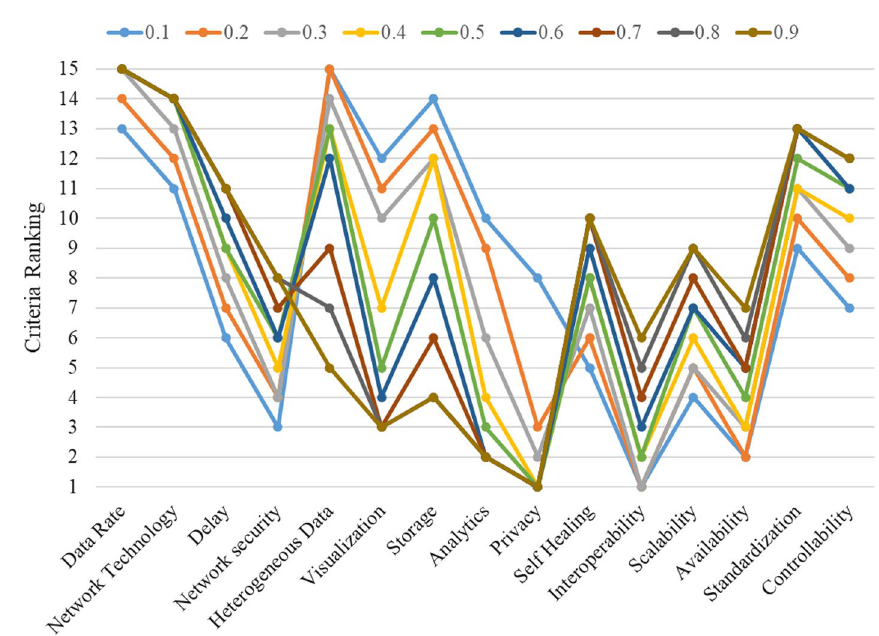
Fig. 3 Criteria Ranking